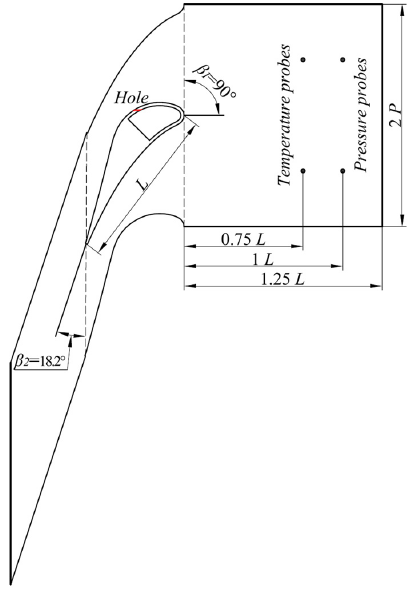
Figure 3. Test section.